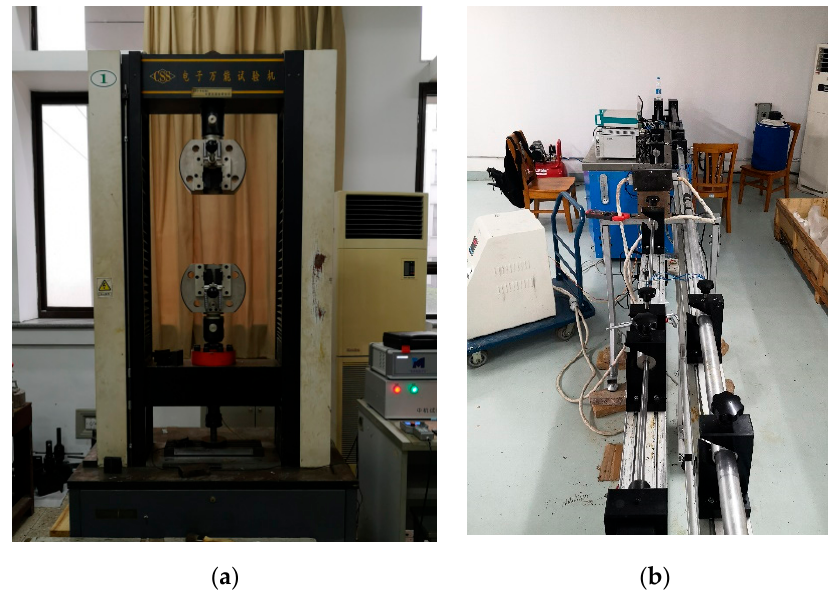
Figure 5. Mechanical test equipment: ( a ) MTS universal testing machine; ( b ) SHPB test equipment.